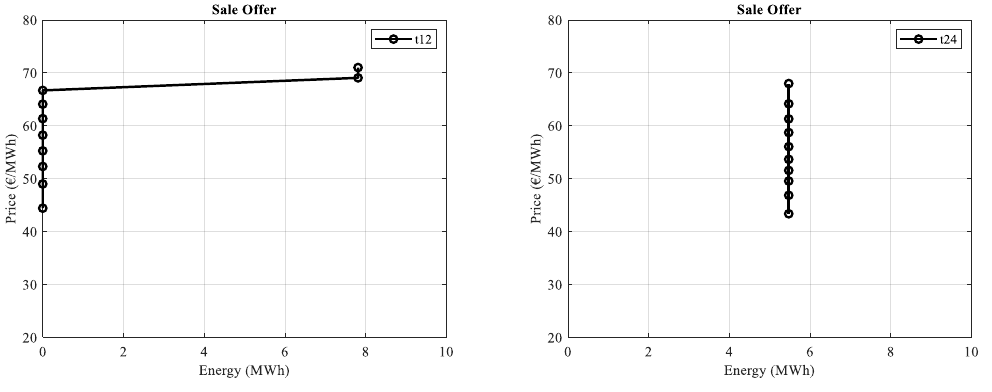
Figure 3. Sale o ff ering curves: left , hour 12; right , hour Figure 3. Sale offering curves: left , hour 12; right , hour 24.